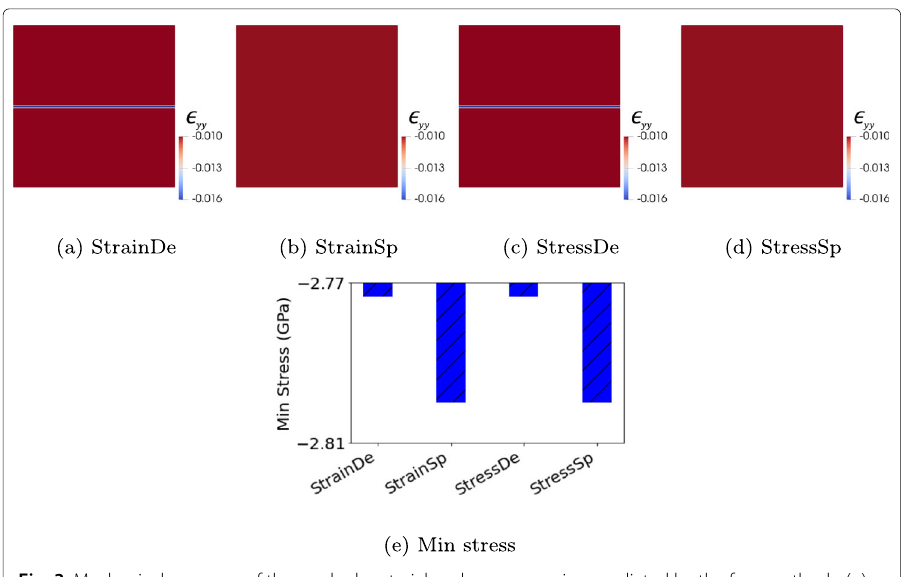
Fig. 3 Mechanical response of the cracked material under compression predicted by the four methods: ( a ) – ( d ) strain distribution for the strain deviatoric, strain spectral, stress deviatoric, and stress spectral methods, respectively; ( e ) minimum compressive stress throughout the